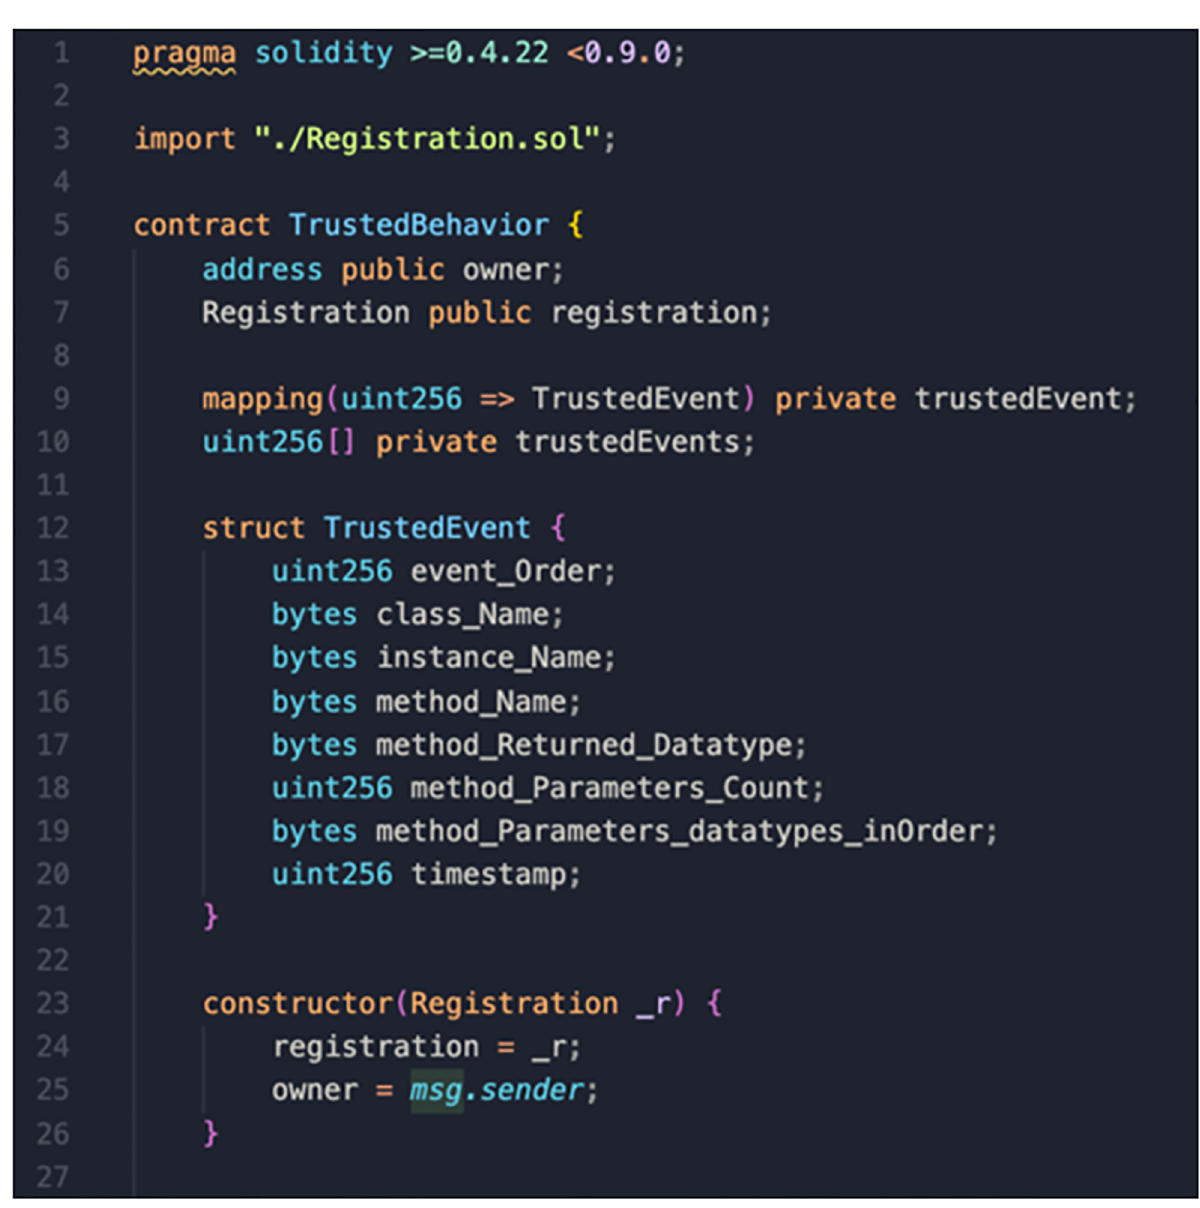
Fig 6. An example of trusted behaviour smart contract